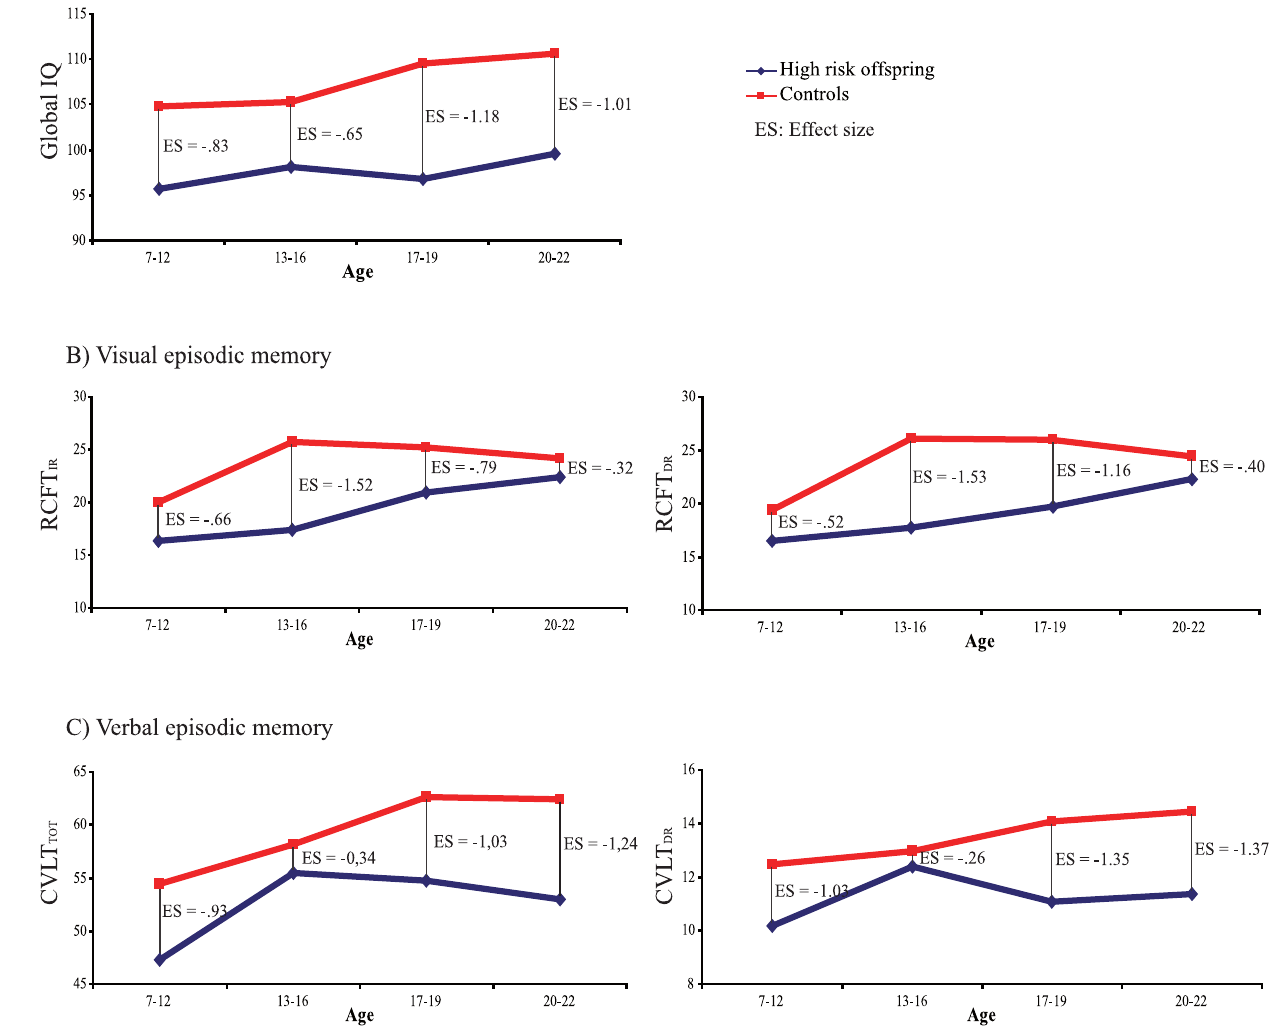
Figure 2. Cross-sectional developmental trajectories representing the evolution in time of the IQ and memory impairments from 7 to 22 years of age. The developmental pattern for Global IQ (A), Visual episodic memory (B) and Verbal episodic memory (C) are illustrated for the controls (red line) and young offspring at genetic risk (blue line). The effect sizes (ES) express the magnitude of the difference between offspring and controls at each age period. The statistically significant Group x Age Periods interaction term obtained only for the two tests of visual episodic memory ( p = .047 for Rey Complex Figure Test immediate recall, RCFT IR , and p = .035 for Rey Complex Figure Test immediate recall, RCFT DR ) suggested that the cognitive differences varied with age for this function. A trend approaching significance could be detected for one of the two tests of verbal episodic memory (CVLT DR , p = .056).